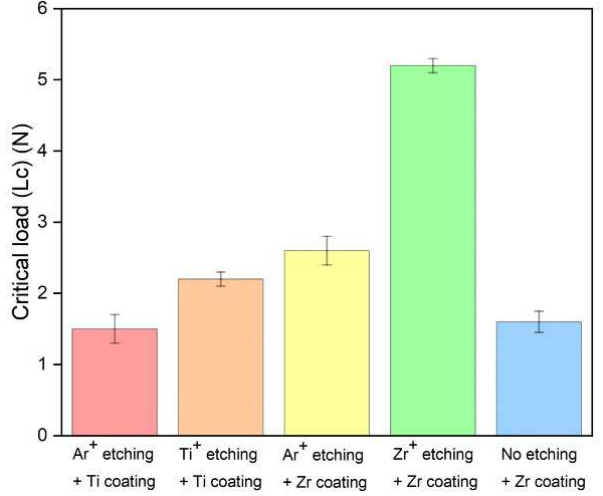
Figure 7. Average critical load value (Lc) of the substrate/metallic bond coat systems obtained from five scratch-test measurements.